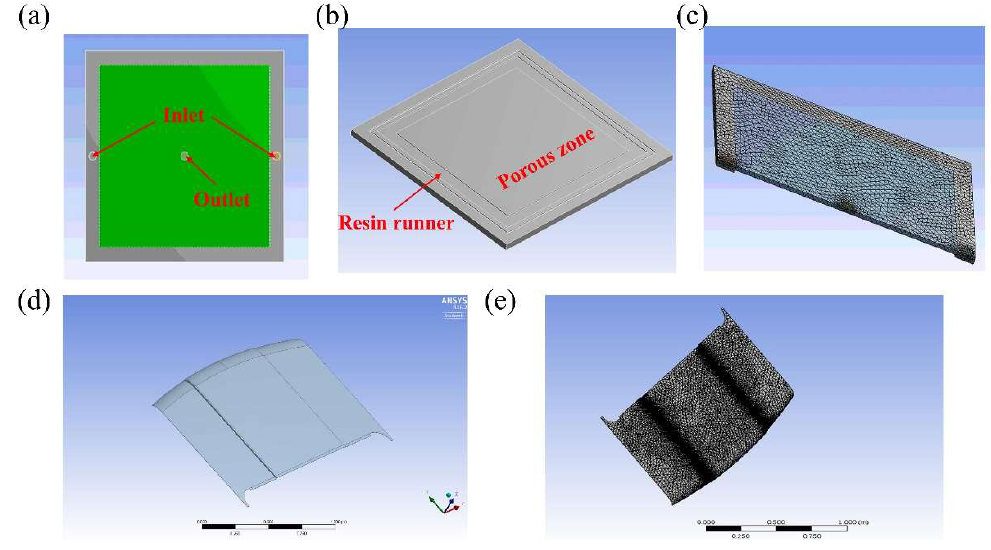
Figure 5. Schematic of ( a ) upper mold of rectangular mold; ( b ) lower mold of rectangular mold; ( c ) mesh of rectangular mold; ( d ) geometry of automotive part mold; ( e ) mesh of automotive part.